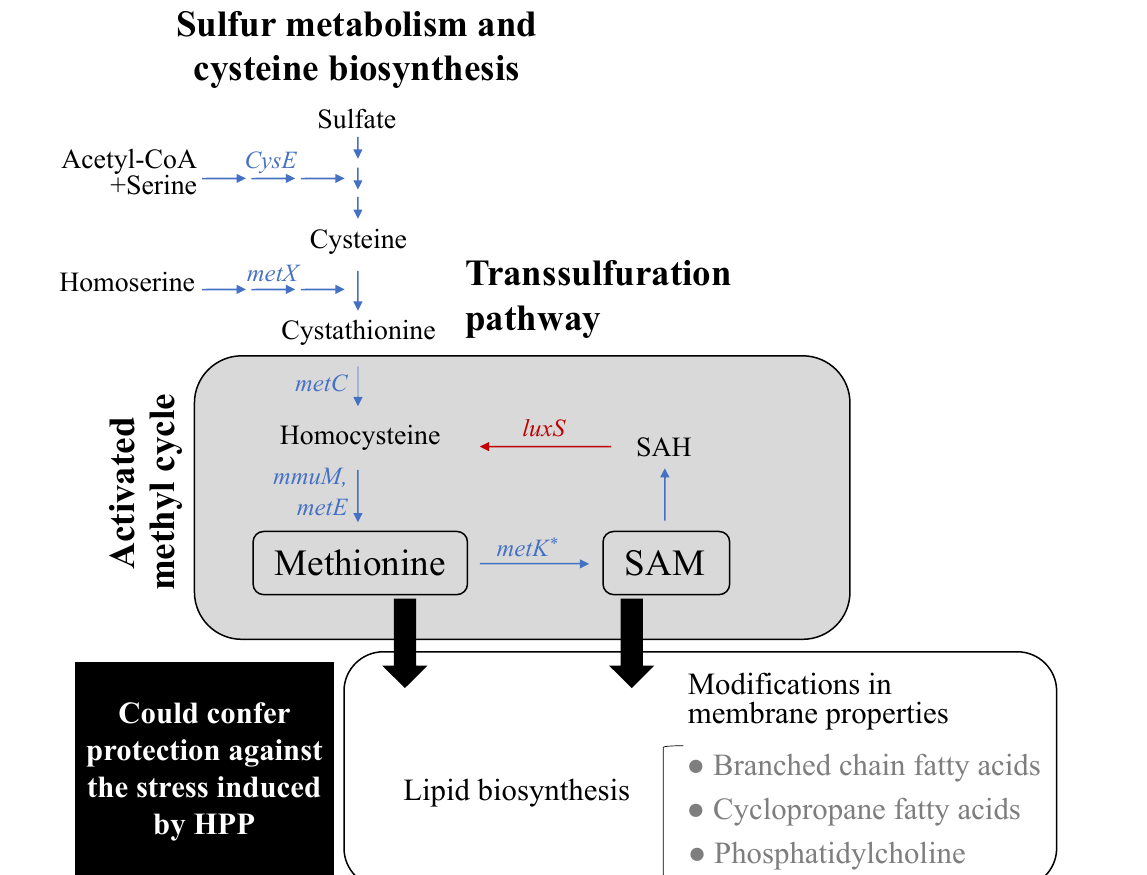
Figure 4. Predicted activation of the methyl cycle in L. monocytogenes CTC1034 and EGDe strains when exposed to lactate and its potential role on the piezo-protective effect exerted by lactate on L. monocytogenes stress induced by HPP. Blue and red arrows and text indicate genes that were upregulated and downregulated, respectively. Genes and proteins: CysE , serine O-acetyltransferase; metX , homoserine O-acetyltransferase; metC , cysteine-S-conjugate beta-lyase; mmuM and metE , homocysteine S-methyltransferases; metK , S-adenosylmethionine synthetase; luxS , S-ribosylhomocysteine lyase; SAM , S-adenosyl-methionine; SAH , S-adenosyl-homocysteine.